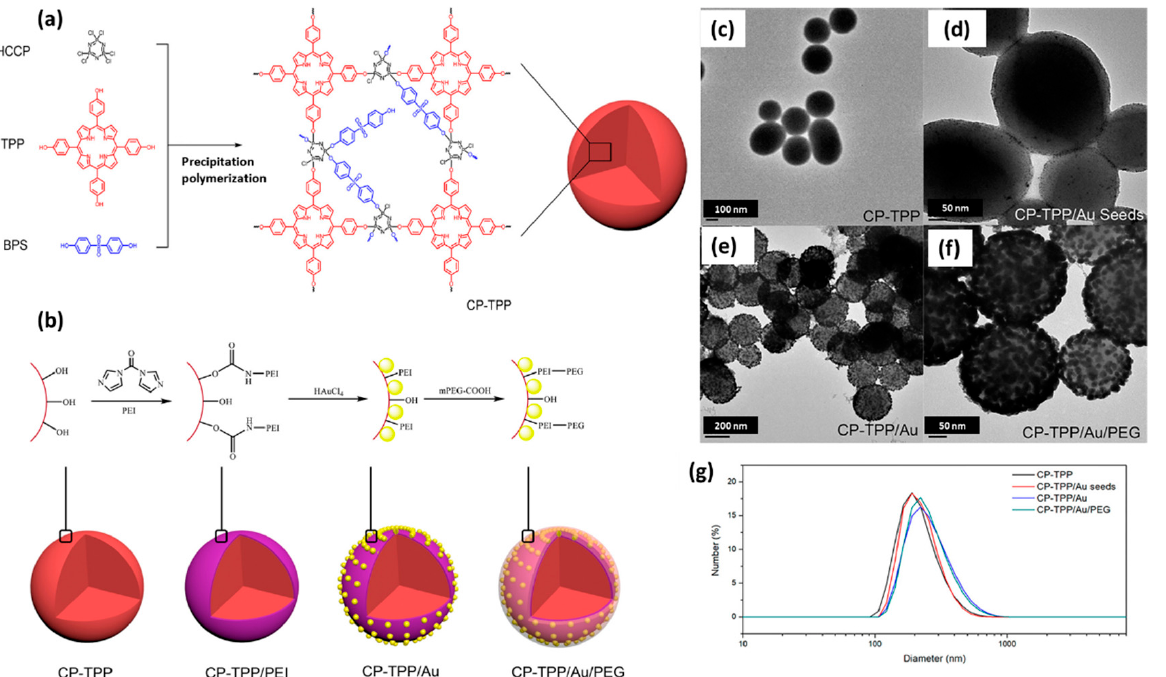
Figure 6. ( a ) Synthetic route and proposed chemical structure of cross ‐ linked CP ‐ TPP nanospheres; ( b ) Synthetic procedure for preparing CP ‐ TPP/Au/PEG nanospheres and ( c – f ) TEM images and ( g ) size distribution of CP ‐ TPP, CP ‐ TPP/Au seeds, CP ‐ TPP/Au, and CP ‐ TPP/Au/PEG nanospheres